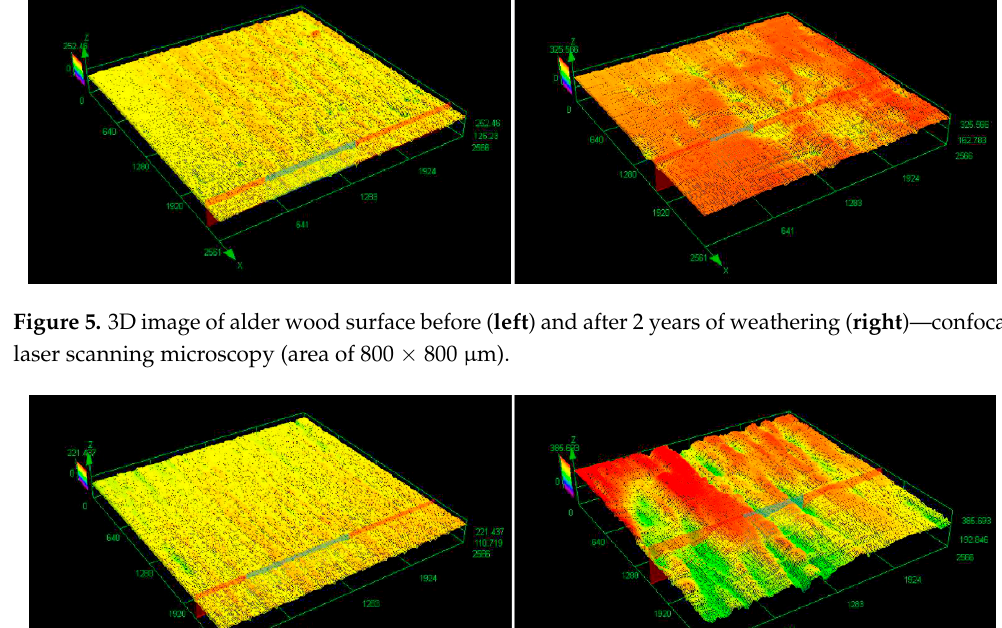
Figure 4. 3D image of poplar wood surface before ( left ) and after 2 years of weathering ( right )— confocal laser scanning microscopy (area of 800 × 800 μ m).